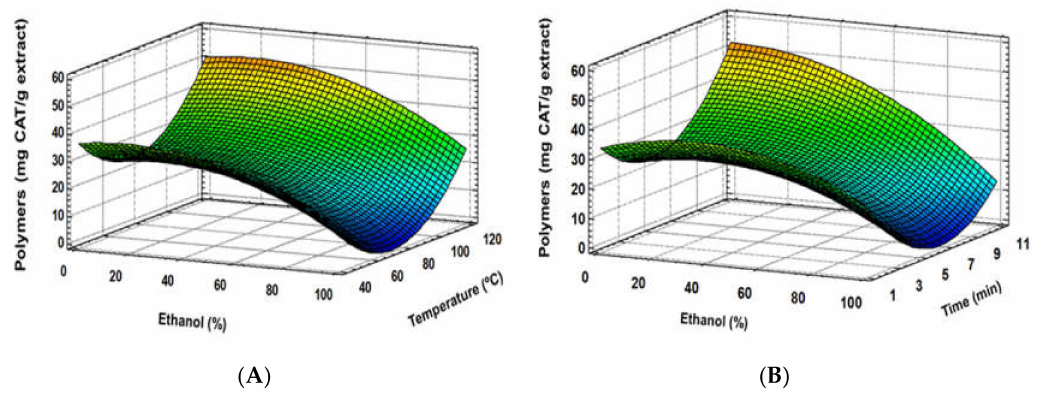
Figure 6. Response surface plots of polymer procyanidins content as a ff ected by independent factors; ethanol (%) vs . temperature ( A ), ethanol (%) vs . time ( B ).